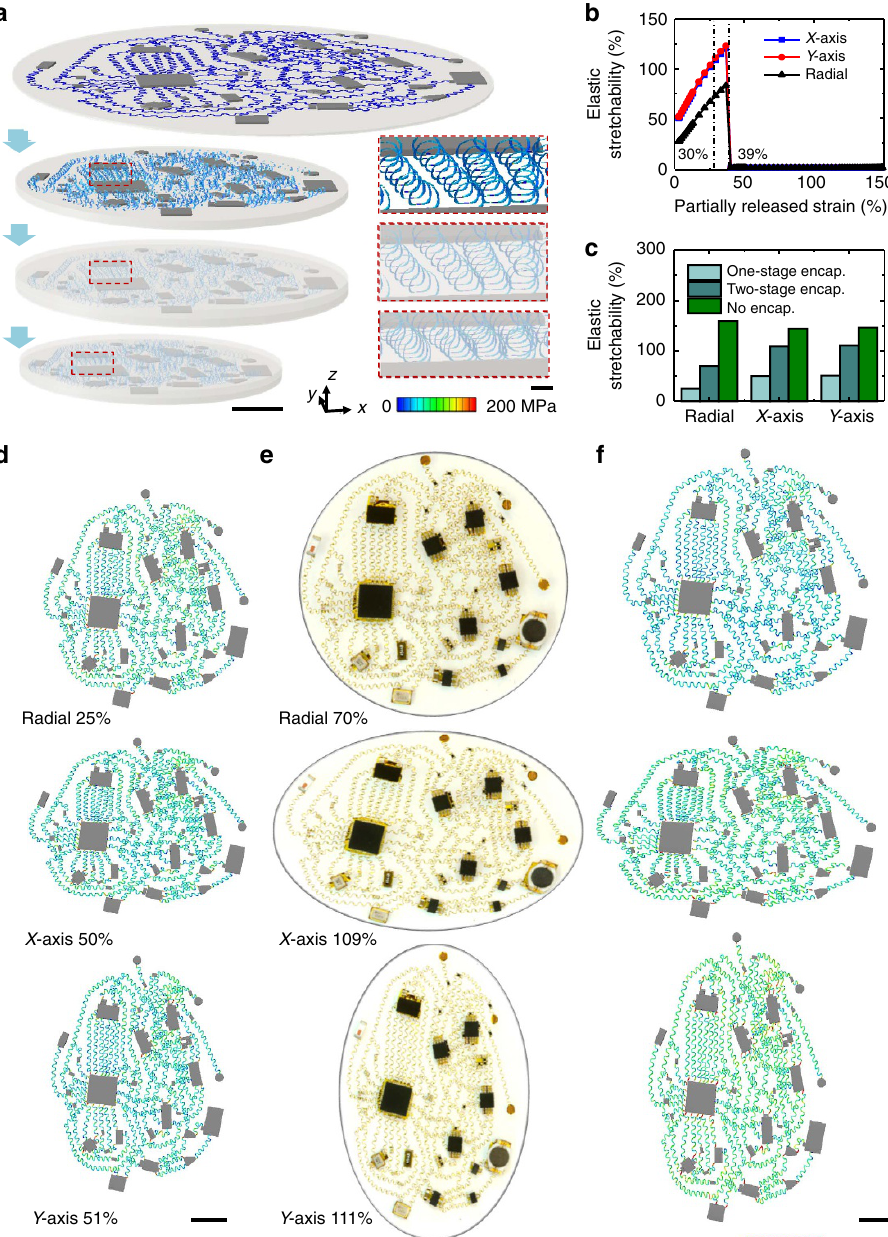
Figure 3 | Strategy for soft encapsulation and system-level mechanics. ( a ) Process for soft encapsulation illustrated with FEA results: first, a collection of electronic components joined by an interconnect network in a 2D serpentine design bond at selective sites to a bi-axially prestrained soft elastomeric substrate (Ecoflex 00-50A/B, Smooth-on, USA; E ¼ 20kPa). Partial release of the prestrain mechanically transforms the 2D serpentines into 3D helices. Coating the entire structure with a thin, low-modulus silicone elastomer (Silbione 4717A/B, Bluestar Silicones, France; E ¼ 3kPa) defines the encapsulation layer. Finally, releasing the remaining prestrain enhances the 3D geometry of the helices and completes the process. The insets correspond to magnified views of a local region. ( b ) Elastic stretchability of a 3D circuit system encapsulated at different states of partially released strain in this two-stage encapsulating process (blue for uniaxial stretching along X axis; red for uniaxial stretching along Y axis; black for radial stretching). ( c ) Bar graph of the elastic stretchability for a 3D circuit system formed by using a one-stage encapsulating process, two-stage encapsulating process and no encapsulation. ( d ) System-level deformation and distribution of stresses determined by FEA with encapsulation introduced after ( d ) full and ( f ) partial release of the prestrain. In all of the FEA images, the colour represents the magnitude of Mises stress in the metal layer. ( e ) Optical images of a device deformed in similar ways. Scale bars, 1cm ( a – d ). The scale bar of the inset of ( a ) is